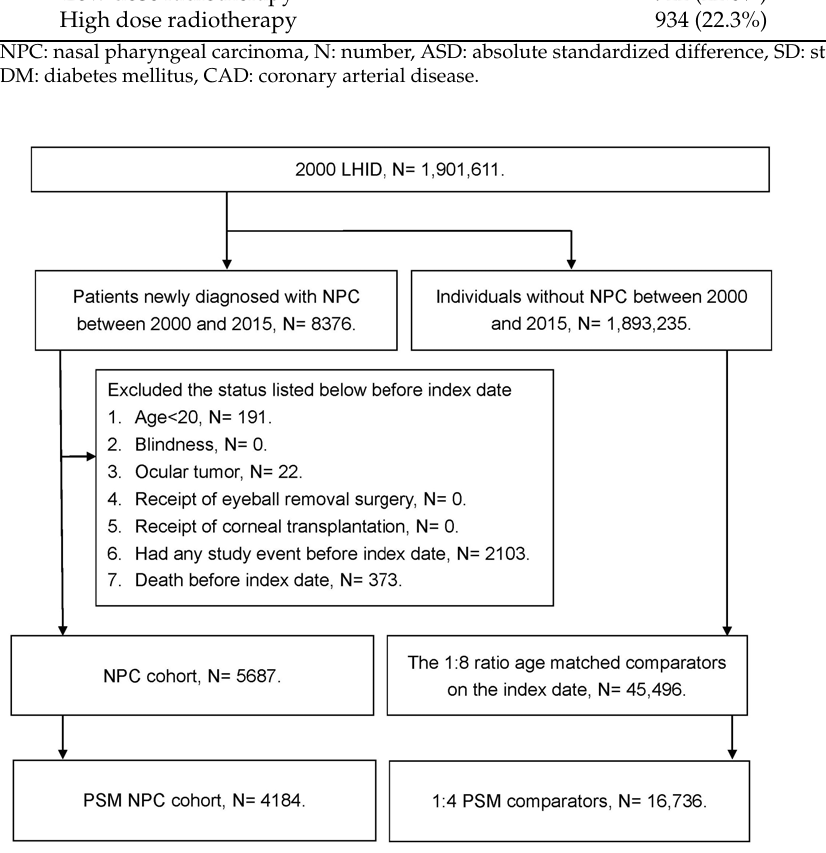
Table 2. Study event between the nasal pharyngeal carcinoma and non ‐ nasal pharyngeal carci ‐ noma patients. Outcome Non ‐ NPC Group NPC Group